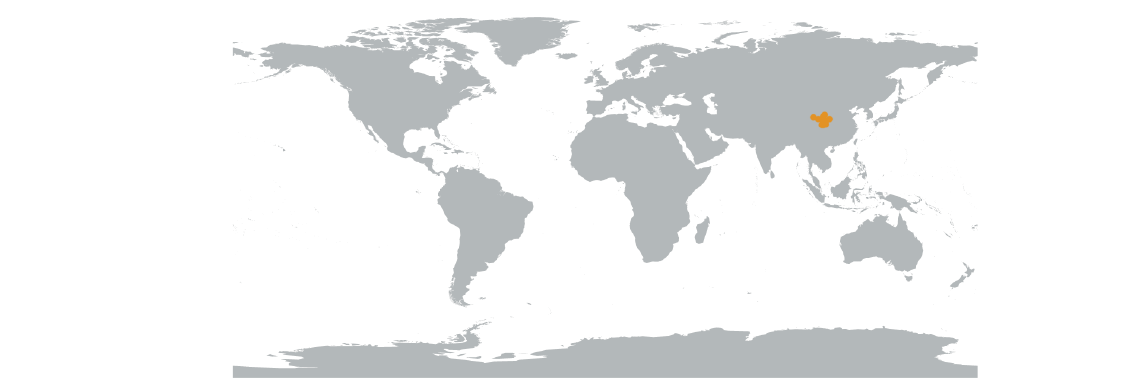
Fig. 7. Distribution of Malus baccata (L.) Borkh . var. gracilis (Rehder)